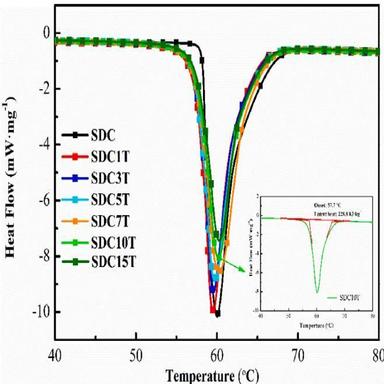
DSC curves of SDC modified by different contents of Ti4O7.